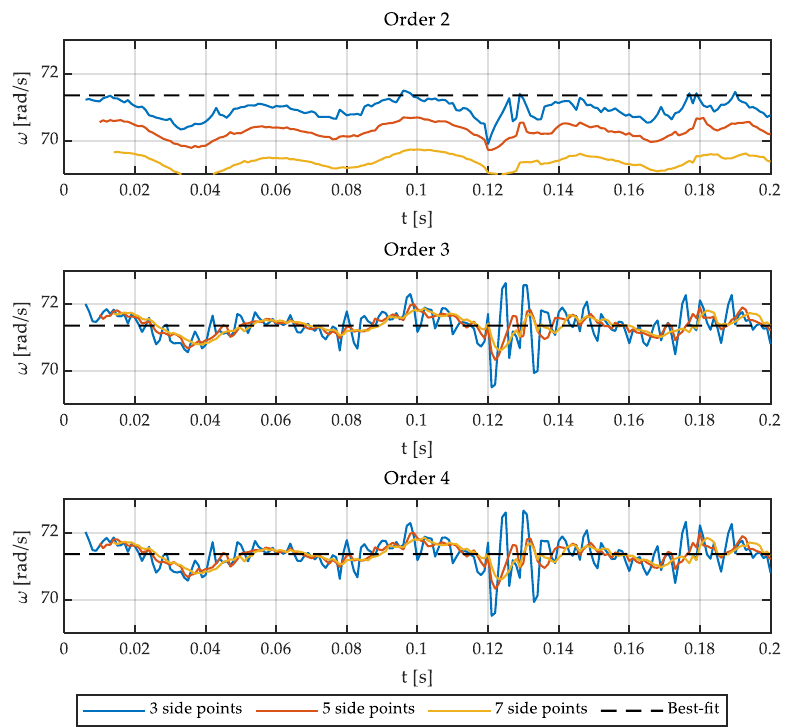
Figure 3. Angular speed fitted to polynomials of order 2, 3, and 4 with 3, 5, and 7 side points.